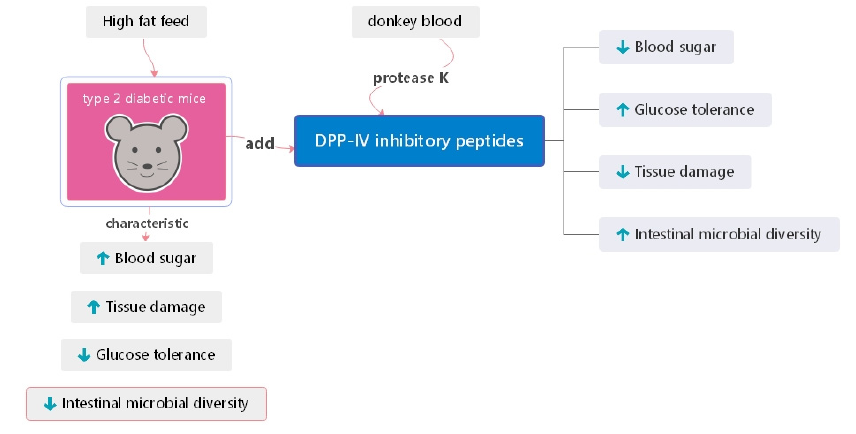
Figure 10. Experimental general mode diagram.